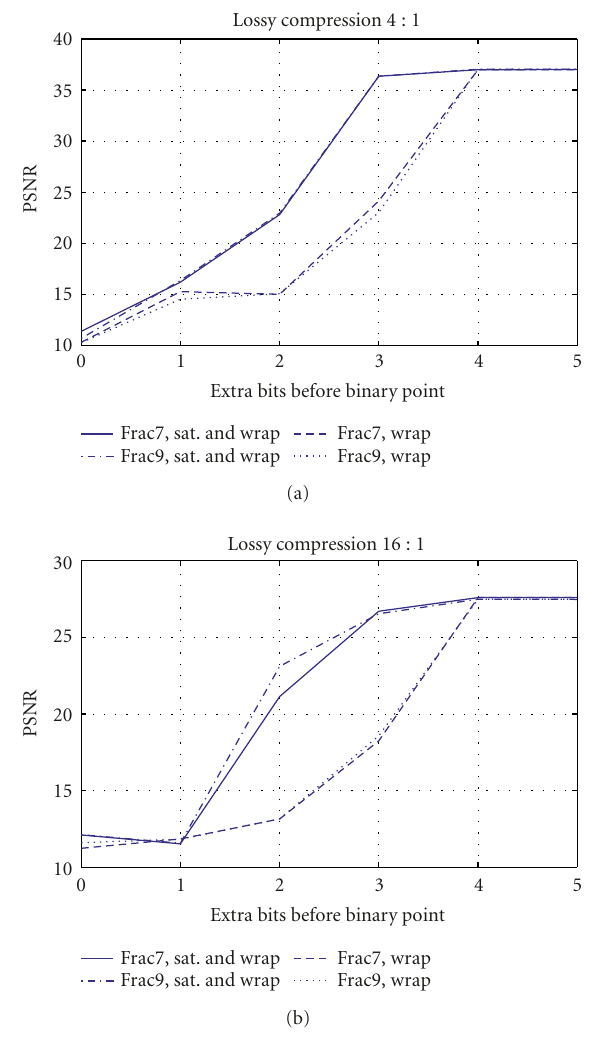
Figure 4: Lossy coding using SPIHT. Wavelet coe ffi cients have 7bits after the binary point (frac7) or 9bits (frac9); the number of bits before the binary points